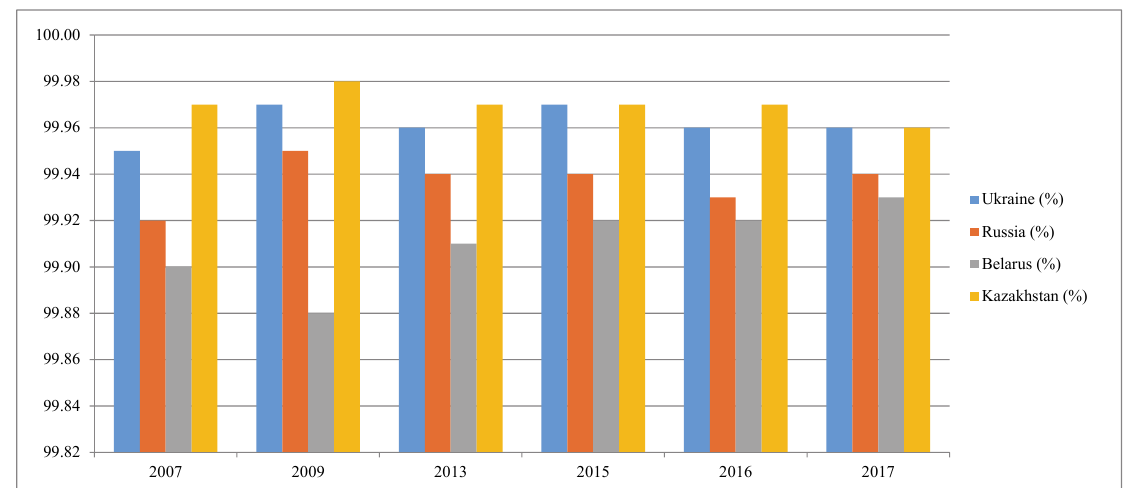
Fig. 4. Dynamics of the share of SMEs in the total number of motor transport enterprises in key coun- tries of the post-Soviet economic space in